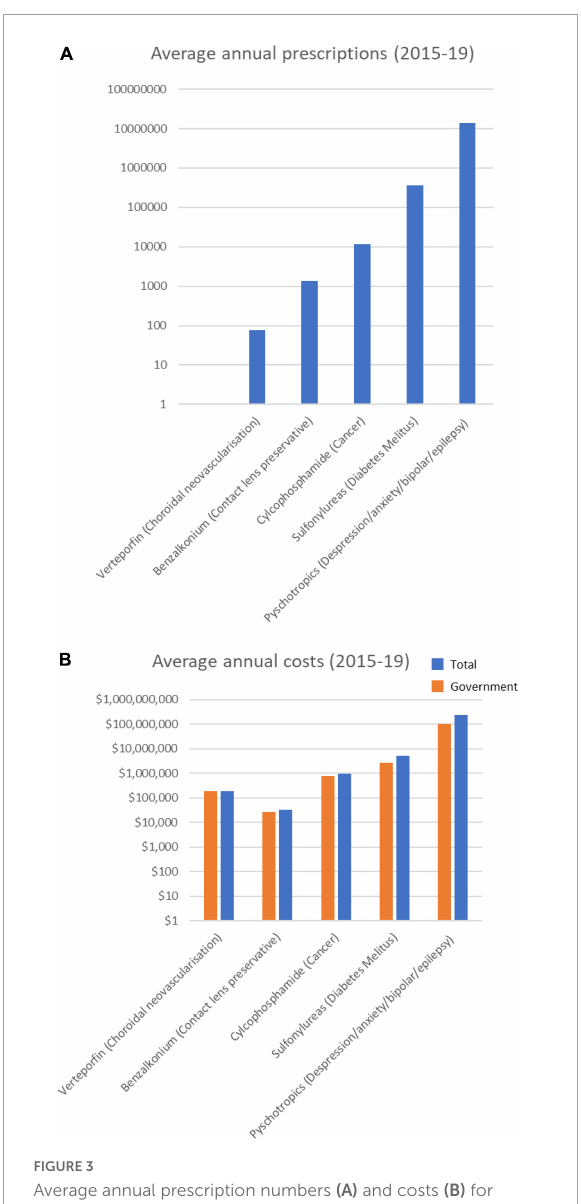
FIGURE3 Average annual prescription numbers (A) and costs (B) for members of the Possible category of drugs associated with cataract, together with typical conditions for which they are